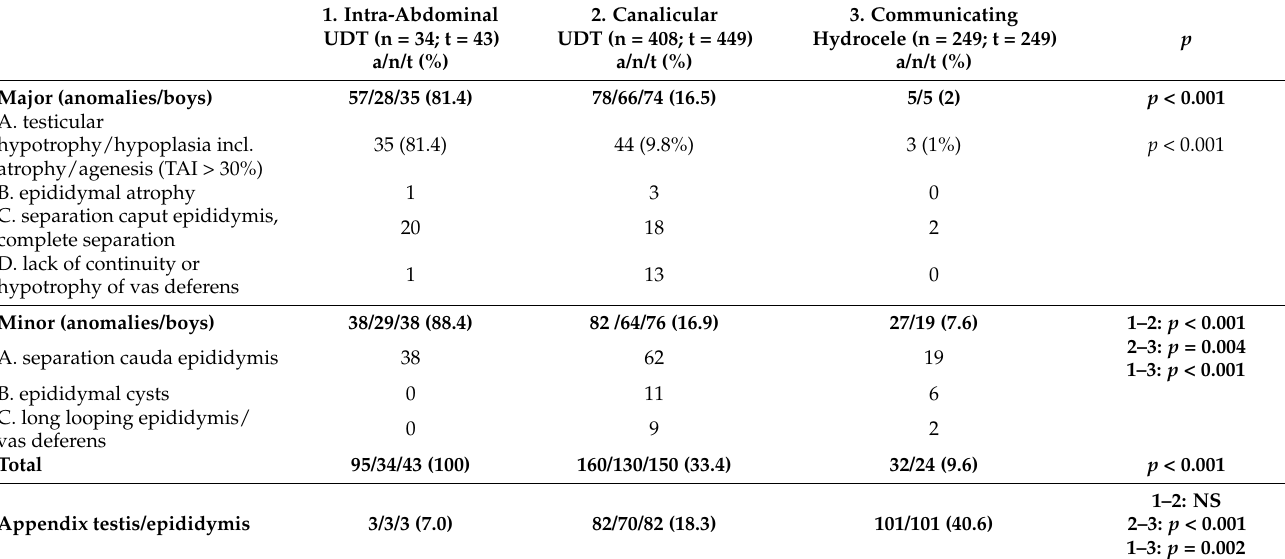
Table 2. Classification and distribution of testicular, epididymal, and vasal anomalies—TEVA